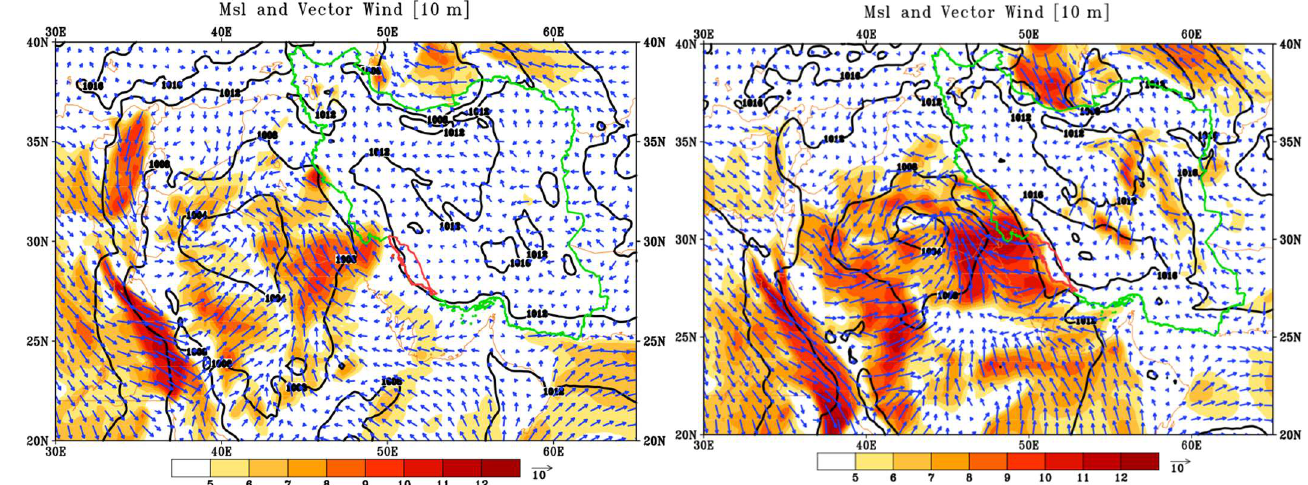
Figure 4. The maps of the mean sea-level pressure and vector wind on 19 March for 00:00 ( left panel ) and 06:00 UTC ( right panel ). Contours indicate the sea level pressure value, while the arrows represent wind speed (color, and the length of vectors) and direction (arrows on vectors).